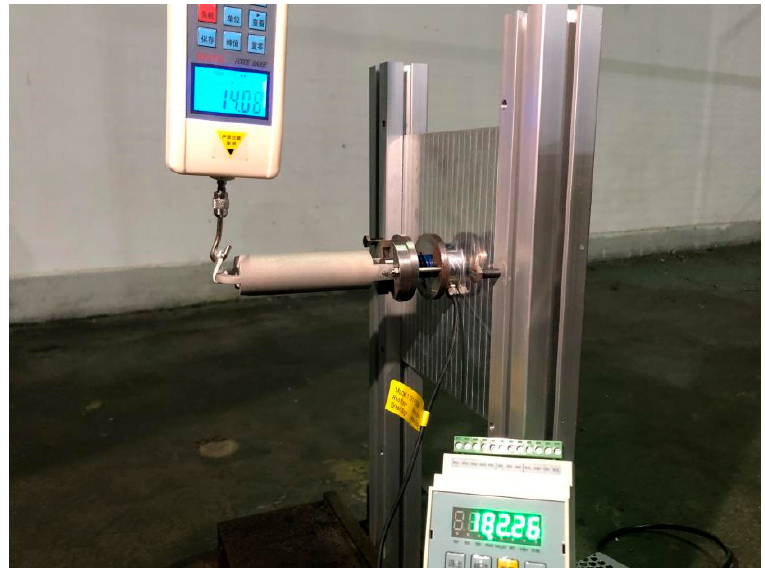
Figure 8. Experimental setup.